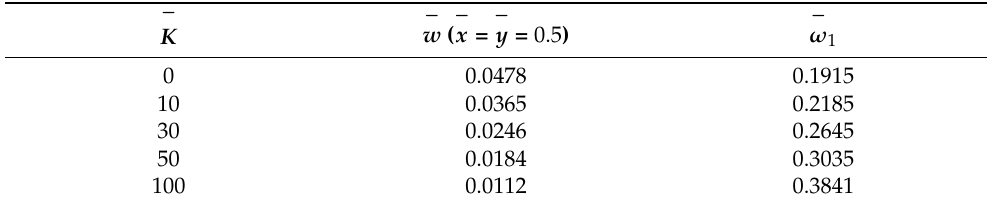
Table 3. Fundamental frequency values and center point deflection values of the plate under